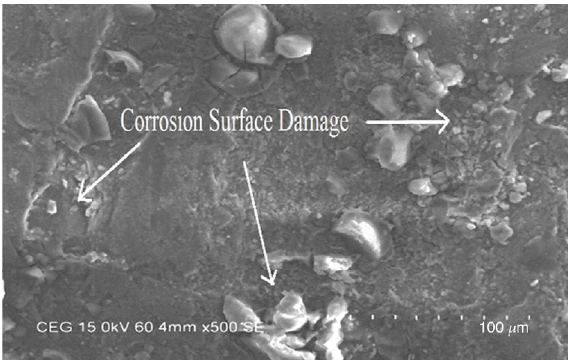
Figure 5: Corrosion surface damages of the Al/GO composite. Figure 3: Nanoparticle distribution in Al/GO composite.